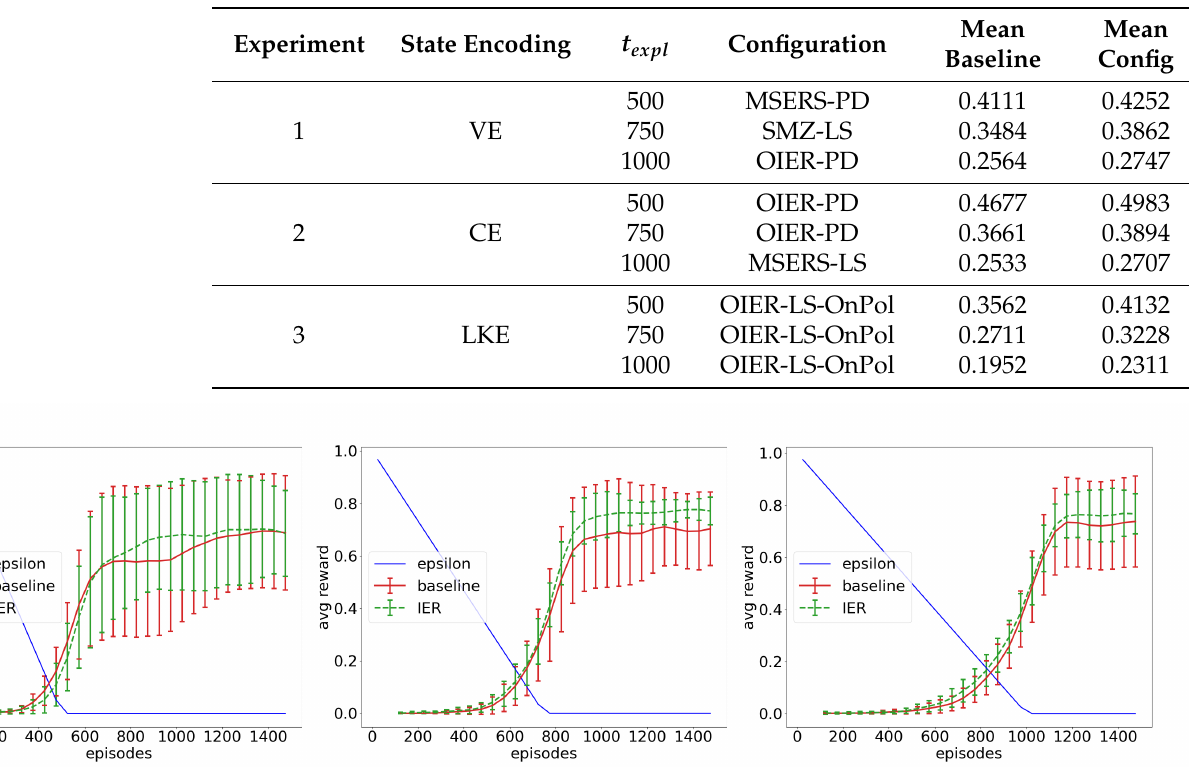
Figure 5. The best results among all conducted experiments with state-encoding VE. The solid red line represents the classical ER serving as baseline to compare with. The dashed green line shows the average reward of the IER approach. The blue line depicts the decaying epsilon. The lines for IER and the baseline represent the repetition averages. t expl = 500. t expl = 750. t expl =